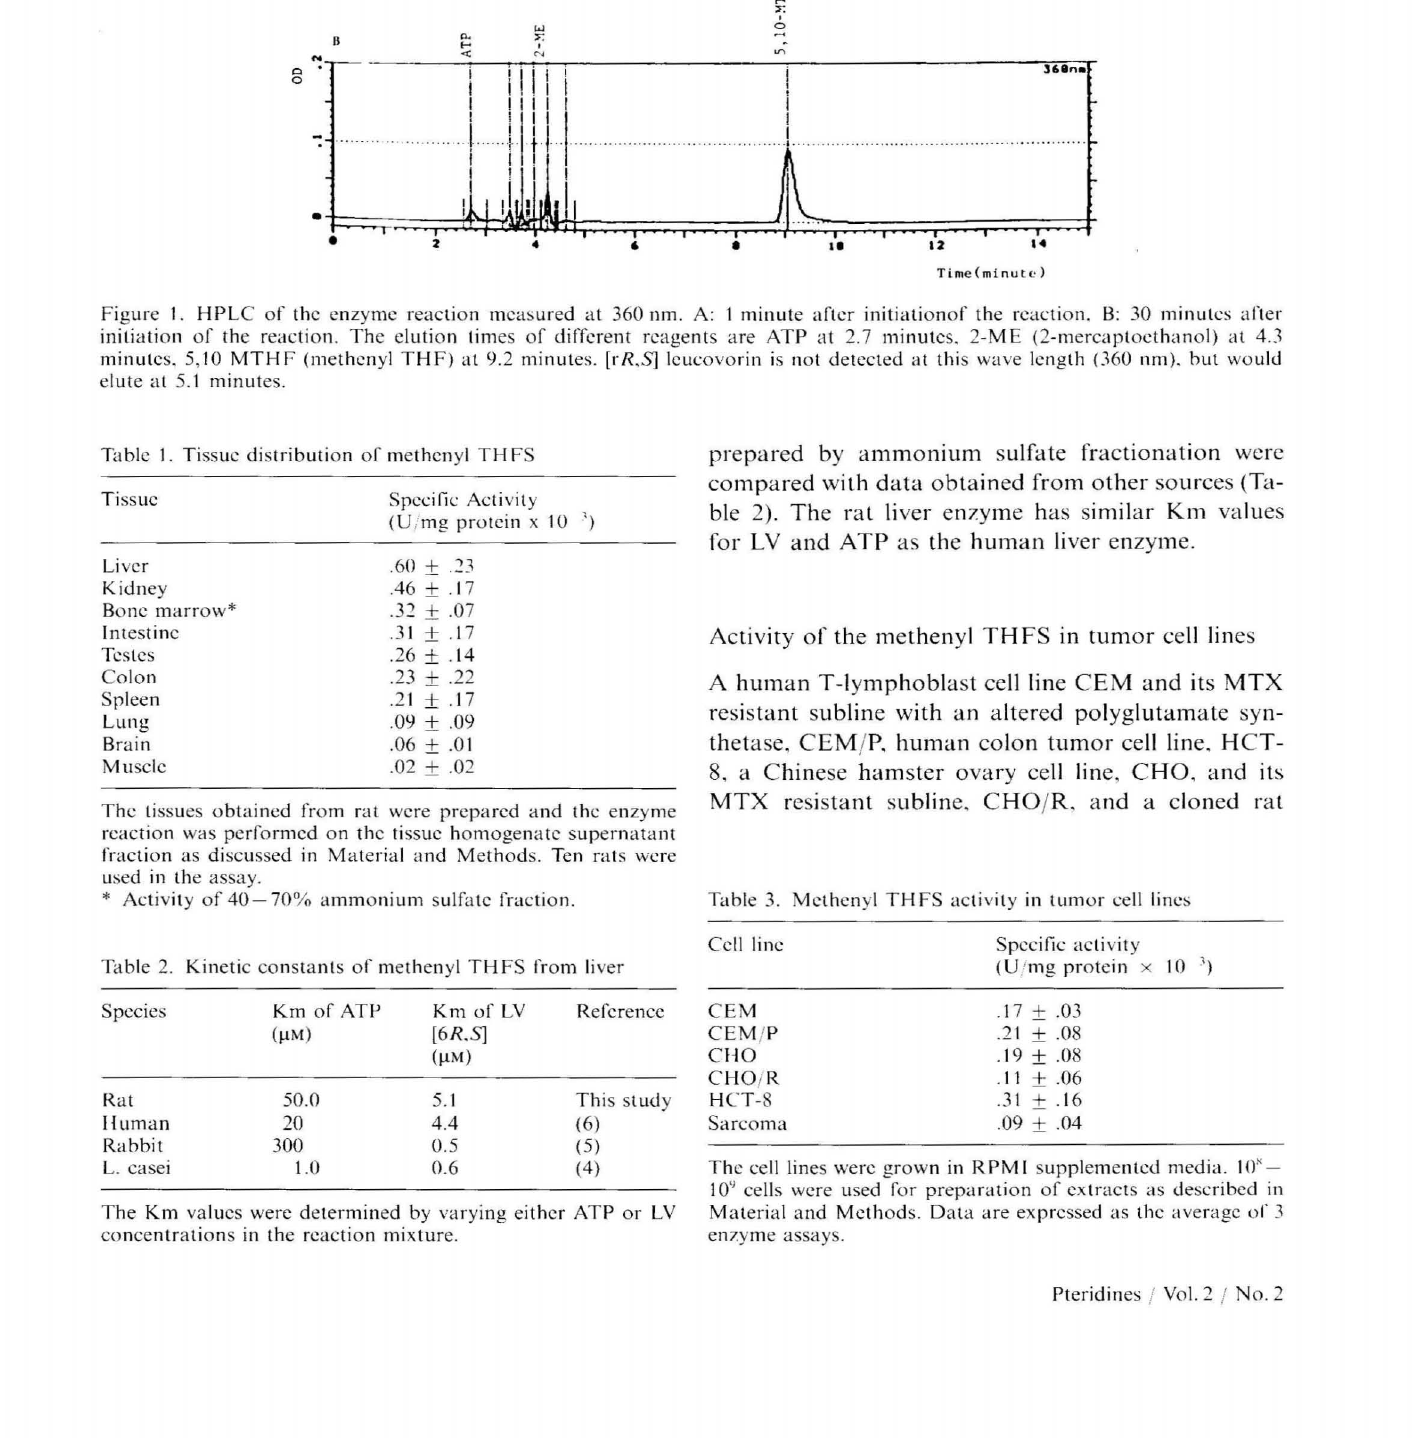
Table 2. Kinetic constants of methenyl TH FS from liver Species